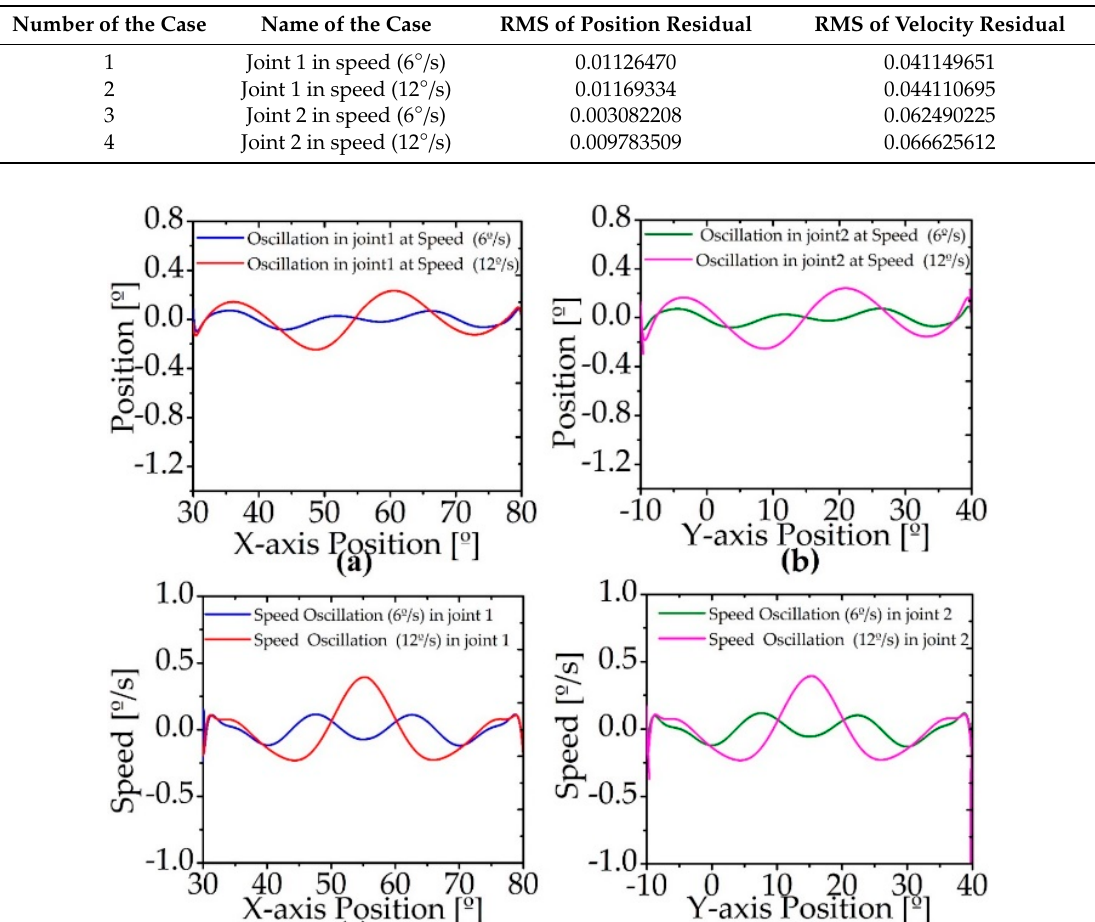
Table 6. The RMSE of both velocity residual and position residual at two speeds in joint 1 ( X -axis) and joint 2 ( Y -axis), (unit: ° ).